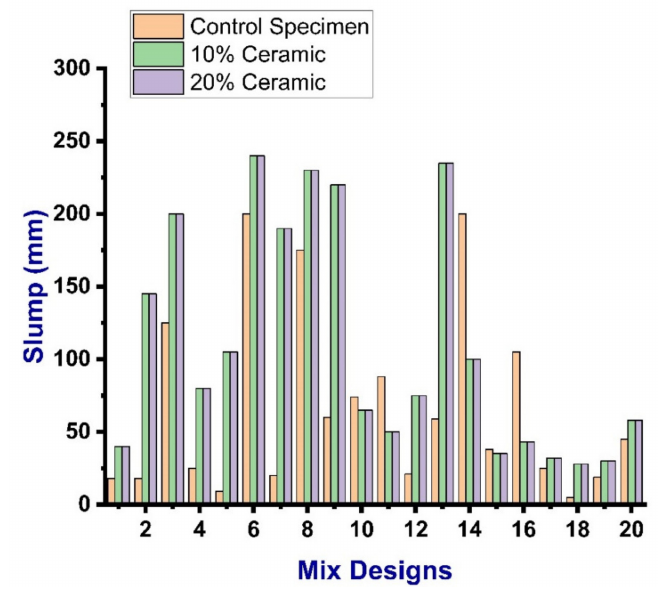
Figure 4. Slump values of the mixes.